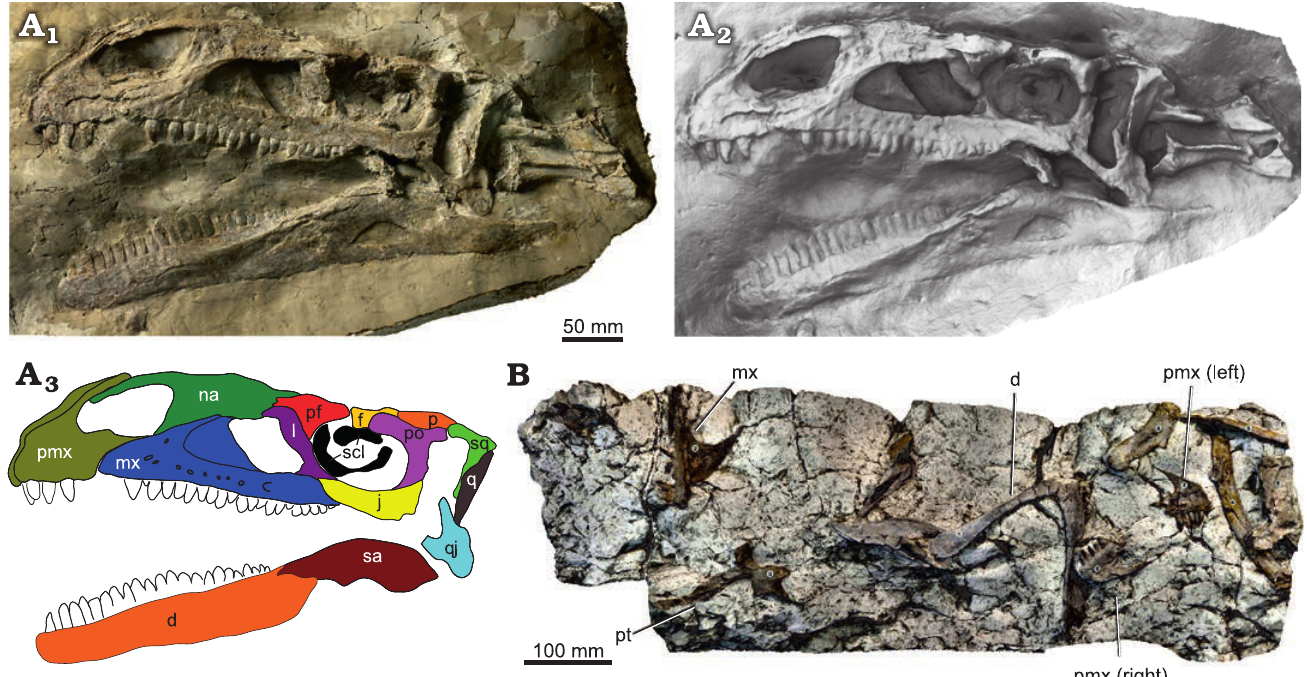
Fig. 7. A . Skull of Plateosaurus trossingensis (NAAG_00011238) from the Triassic of Frick, Switzerland. Photograph in lateral view (A 1 ) (by Georg Oleschinski, University of Bonn, Germany); ambient occlusion of photogrammetric model (A 2 ); interpretative diagram (A 3 ). B . Orthophoto of photo - grammetric model of disarticulated skull material (NAAG_00011239). Abbreviations: d, dentary; f, frontal; fo, foramen magnum; j, jugal; mx, maxilla; na, nasal; p, parietal; pf, prefrontal; pmx, premaxilla; po, postorbital; pt, pterygoid; q, quadrate; qj, quadratojugal; sa, surangular; scl, sclerotic ring; sq,